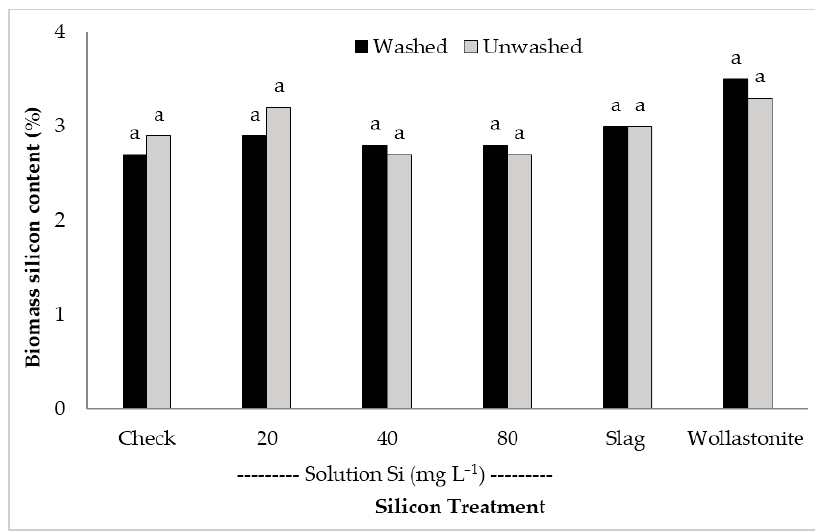
Figure 4. Silicon content of washed and unwashed rice biomass at flowering with different silicon treatments. Bars labeled with the same letter are not significantly different at P < 0.05 according to Tukey’s test. Slag and wollastonite rates: 690 and 1190 kg Si ha − 1 , respectively.